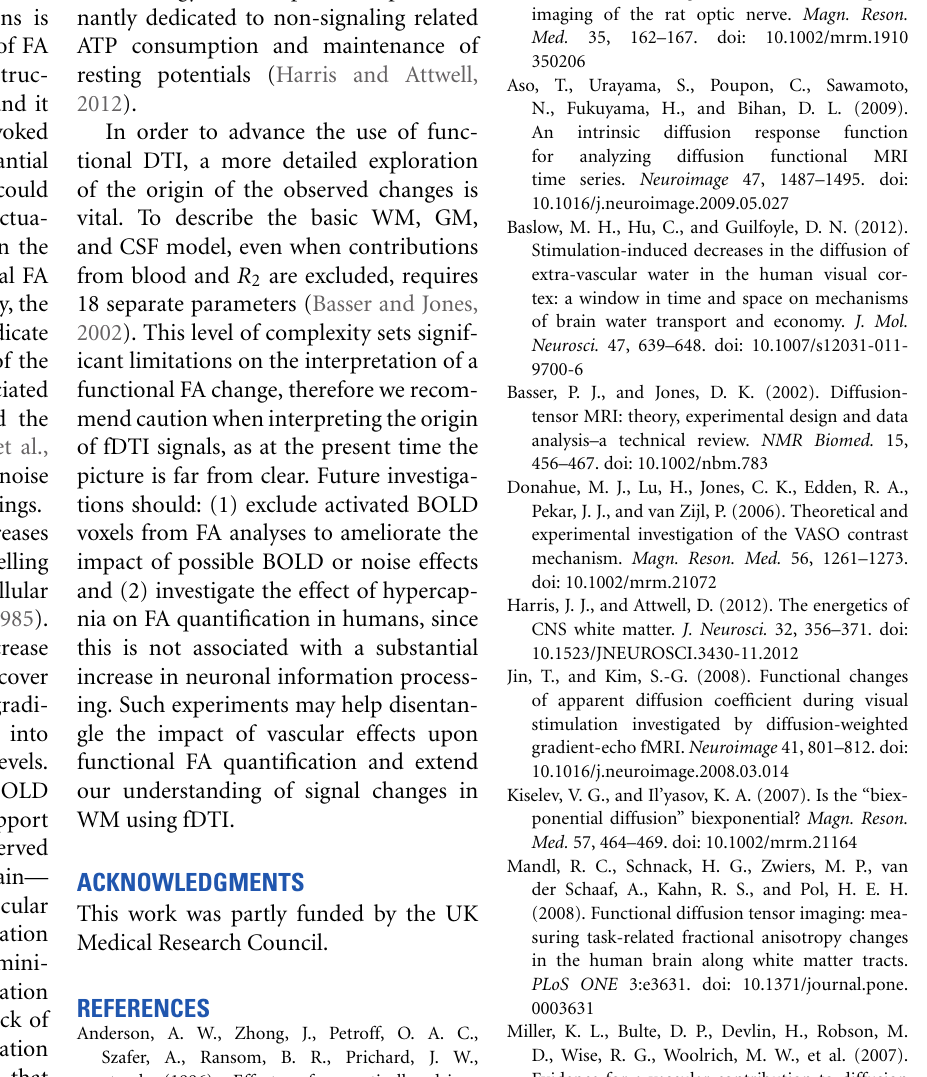
after using standardized white